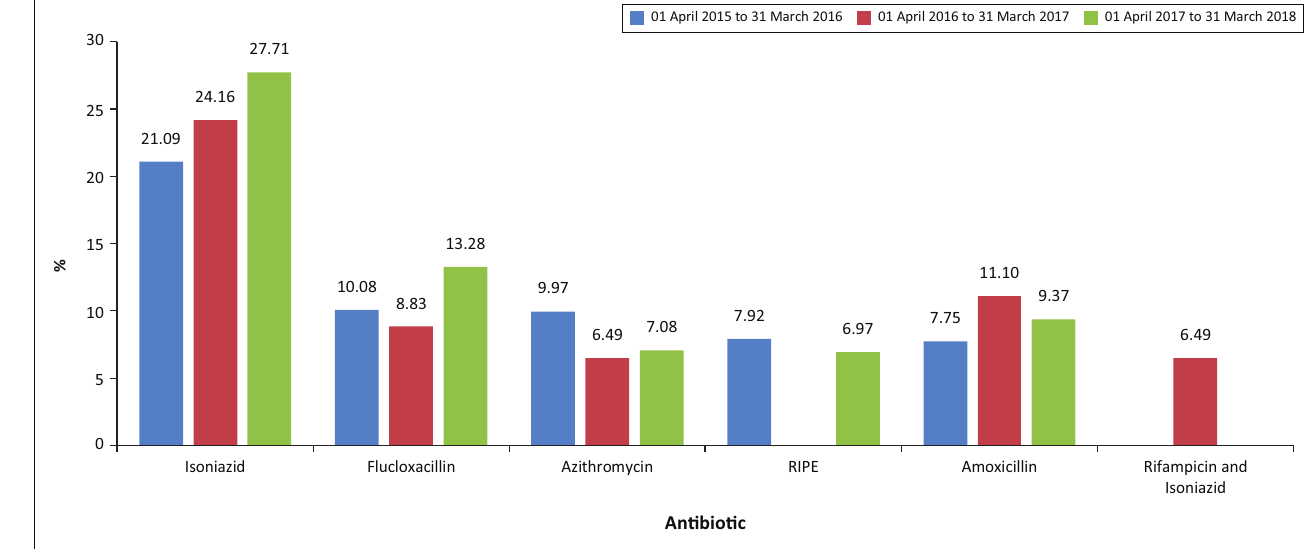
FIGURE 1: Percentage cost of total antibiotic expenditure between 01 April 2015 and 31 March